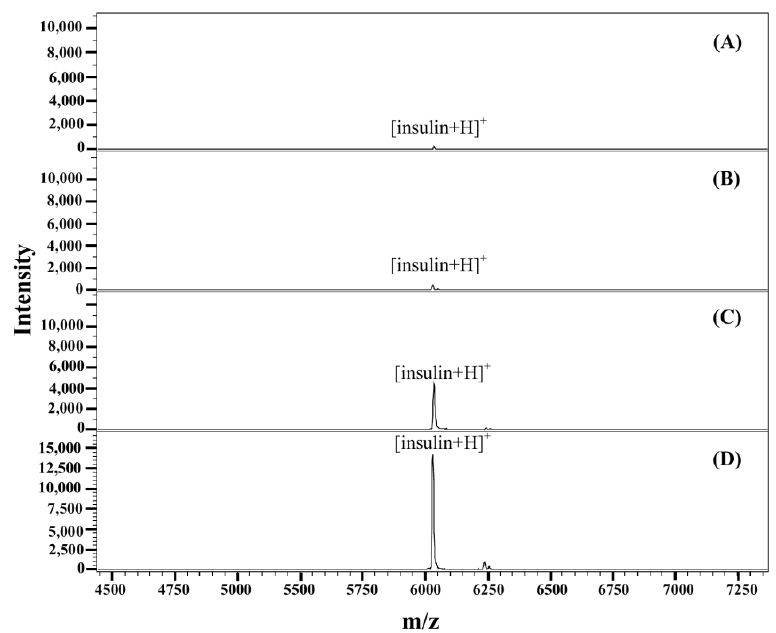
Figure 2. Mass spectra of insulin obtained with different membranes: ( A ) PVDF, ( B ) PTFE, ( C ) MCE, and ( D ) nylon. Experimental conditions: insulin volume, 3 µ L; SA solution volume, 3 µ L; and insulin concentration, 5.0 µ M. The mass spectrum was obtained by averaging 200 mass spectra using laser energy that slightly exceeded the